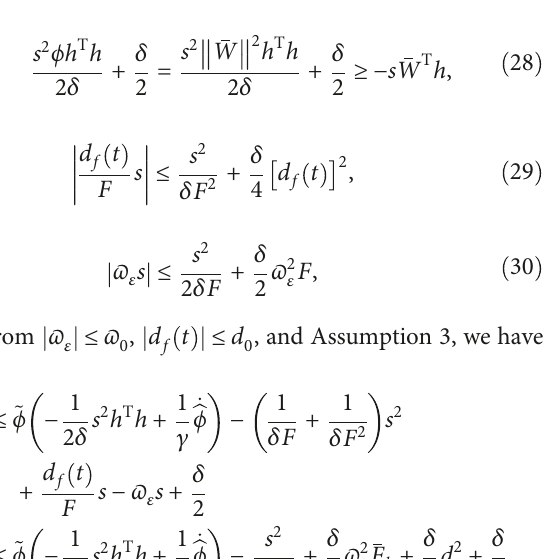
Figure 2: The proposed control